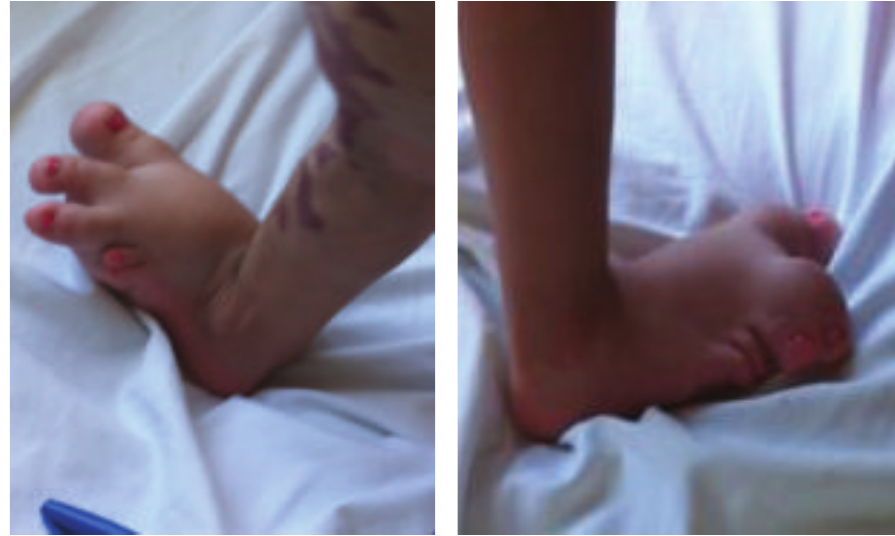
Figure 5: Syndactyly of the toes in both feet.